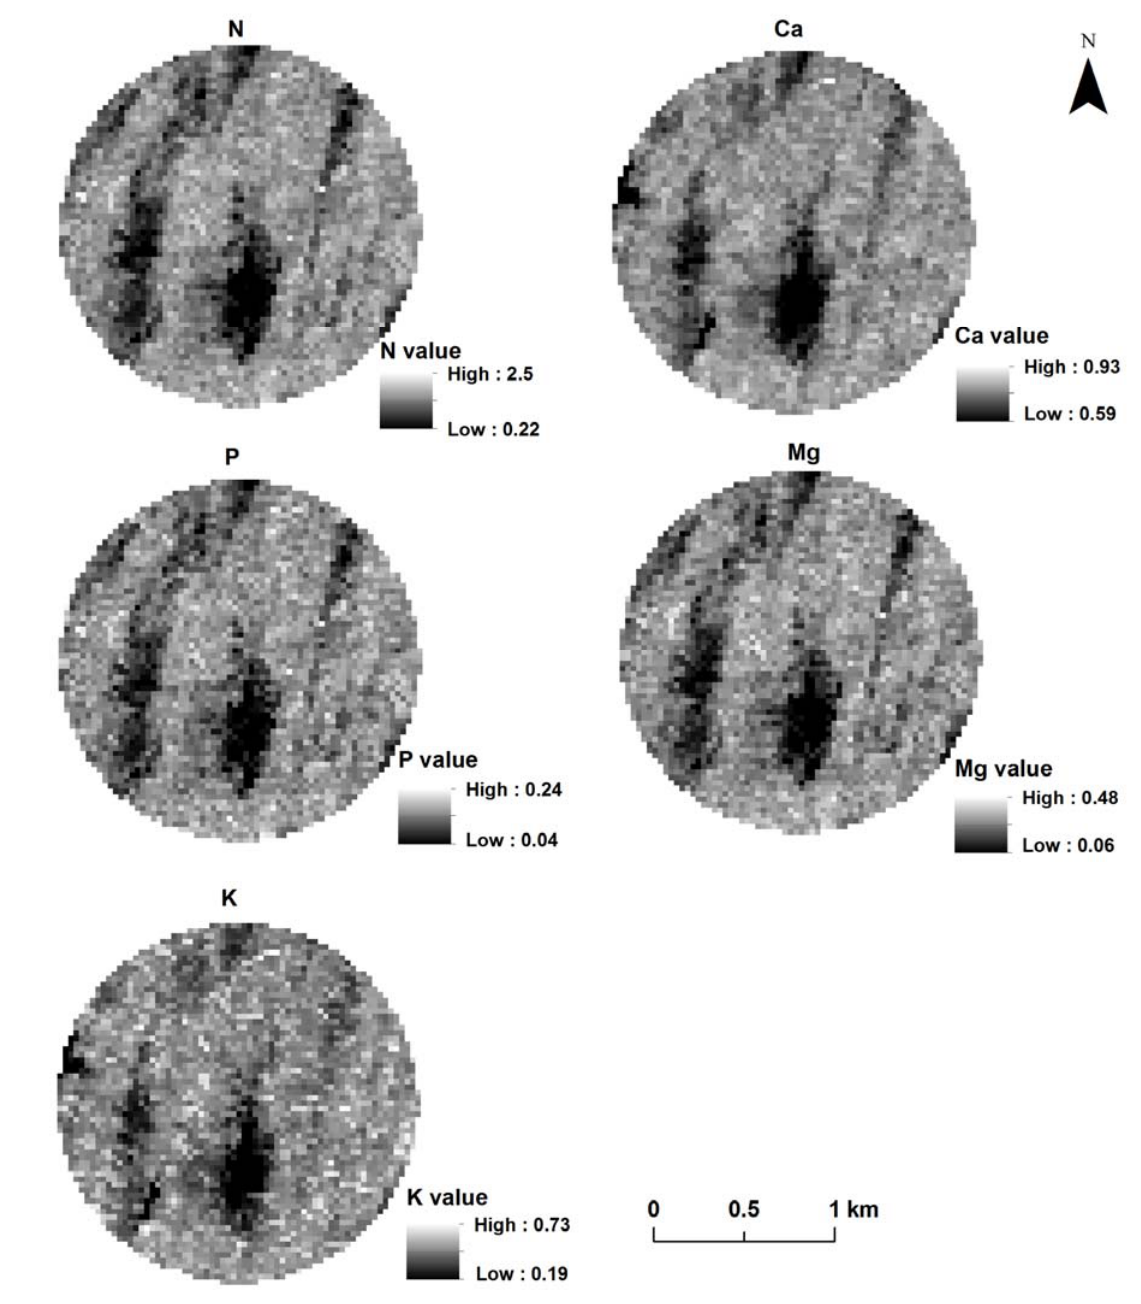
Figure 9. Spatial distribution of macronutrient concentration at canopy level at Groundhog River Flux Station (GRFS). Units of concentration are %. Maps are generated from partial least squares (PLS) regression models using Hyperion